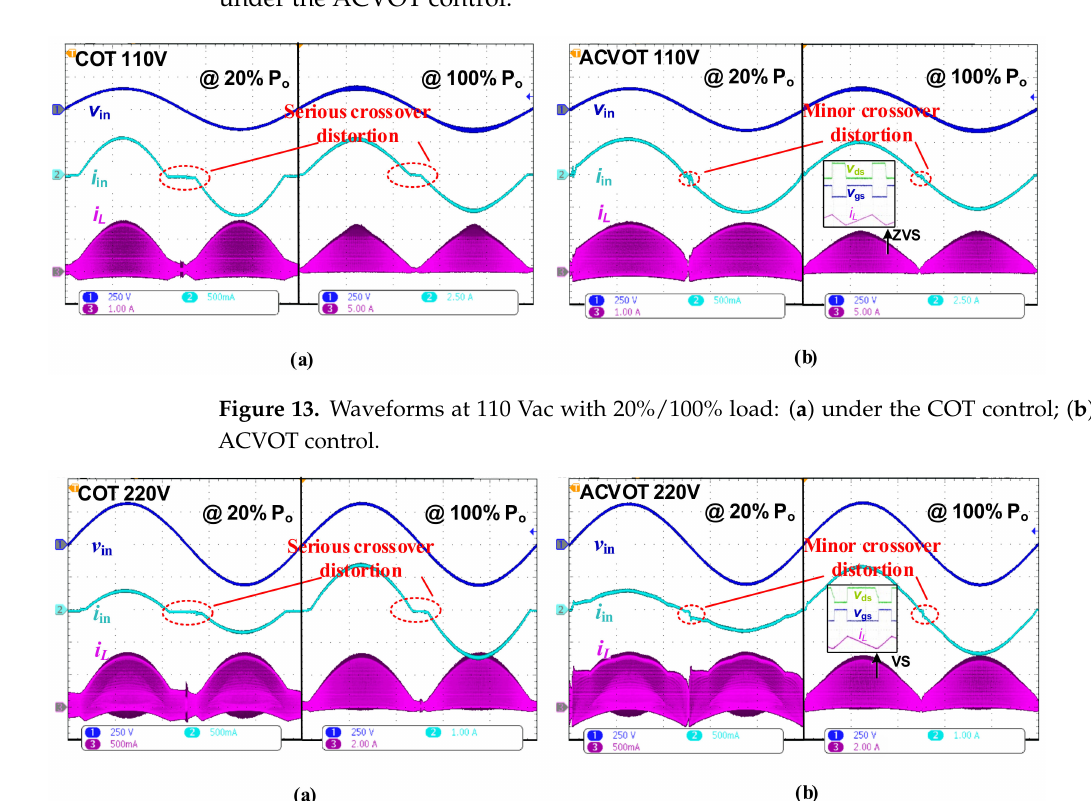
Figure 14. Waveforms at 220 Vac with 20%/100% load: ( a ) under the COT control; ( b ) under the ACVOT control.